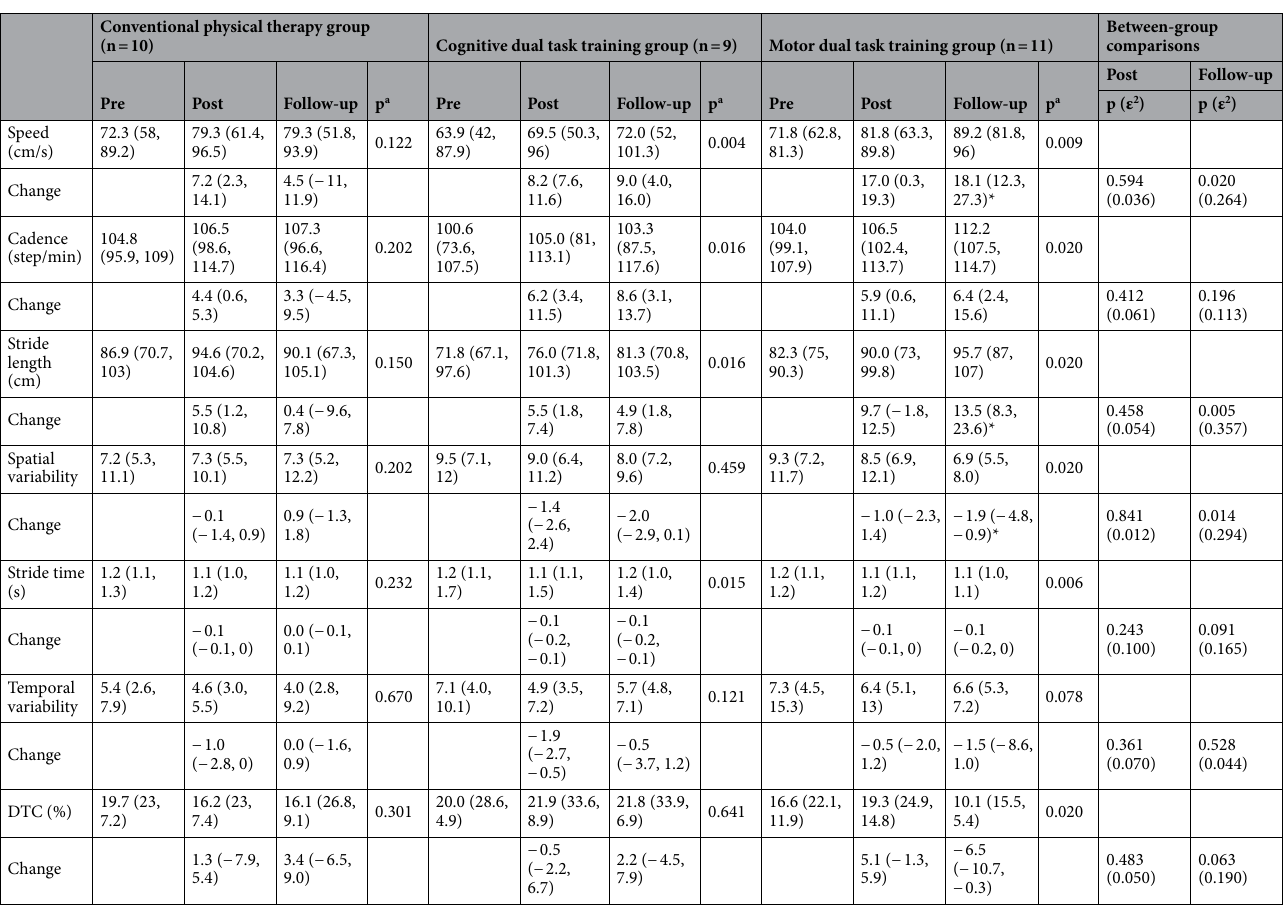
Table 2. Comparisons of cognitive dual task walking performance after training at different time point. Values are median (interquartile). Change values were calculated by subtracting the baseline data from the post-training data (Post) or by subtracting the baseline data from the follow-up data (Follow-up). a p value for within-group comparison using Friedman test. *p < 0.05 as compared with conventional physical therapy